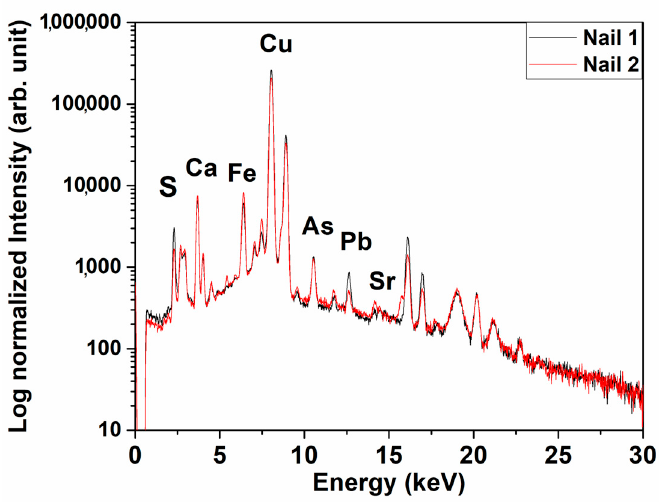
Figure 3. Two representative p XRF spectra of the Figure 3 . Two representative p XRF spectra of the nails.